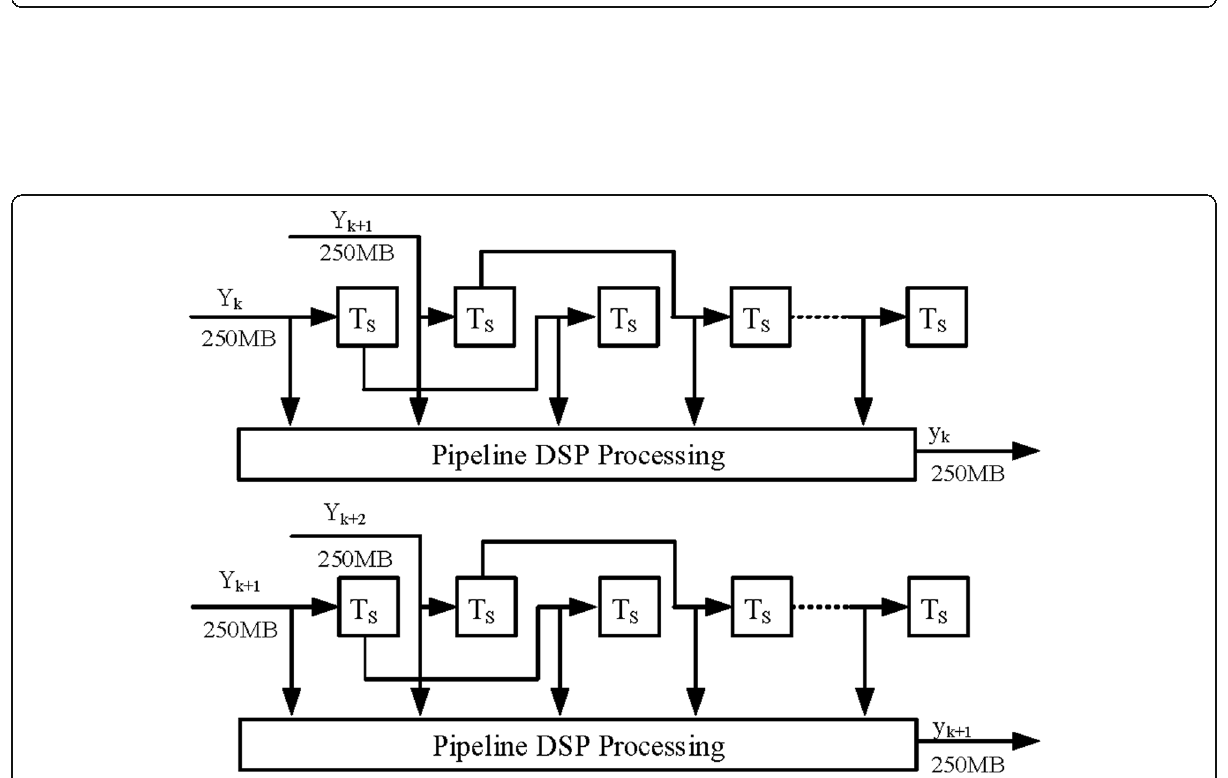
Fig. 7 Transversal linear structure after orhogonal improvement. This figure shows a transversal linear structure after orthogonal improvement